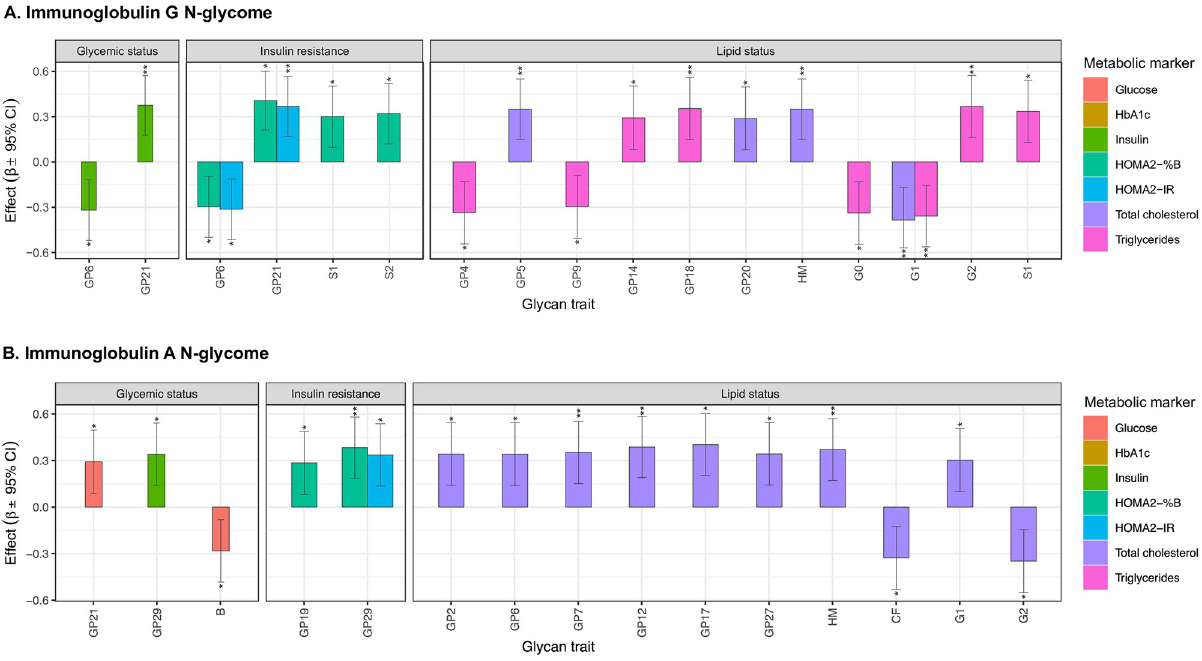
Fig 3. Significant associations of IgG and IgA N-glycan traits with metabolic parameters in pregnancy. Effect size represents beta coefficient estimated through regression model. Error bars represent 95% confidence intervals. B—bisecting GlcNAc; CF—core fucosylation; GP—glycan peak; G0 –agalactosylation; G1 –monogalactosylation; G2 –digalactosylation; HM—high mannose; S1 –monosialylation; S2 –disialylation; * –adjusted p-value in range 0.05–0.01; ** –adjusted p-value in range 0.01–0.001; *** –adjusted p-value <